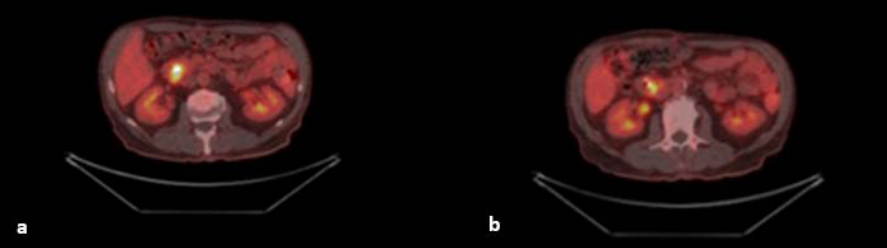
Figure 2. ( a , b ) Axial fused PET/CT images show the lesion on the ampullary area. Increased uptake along the common bile duct stent. Focally increased radiopharmaceutical uptake in the intestinal propellers.